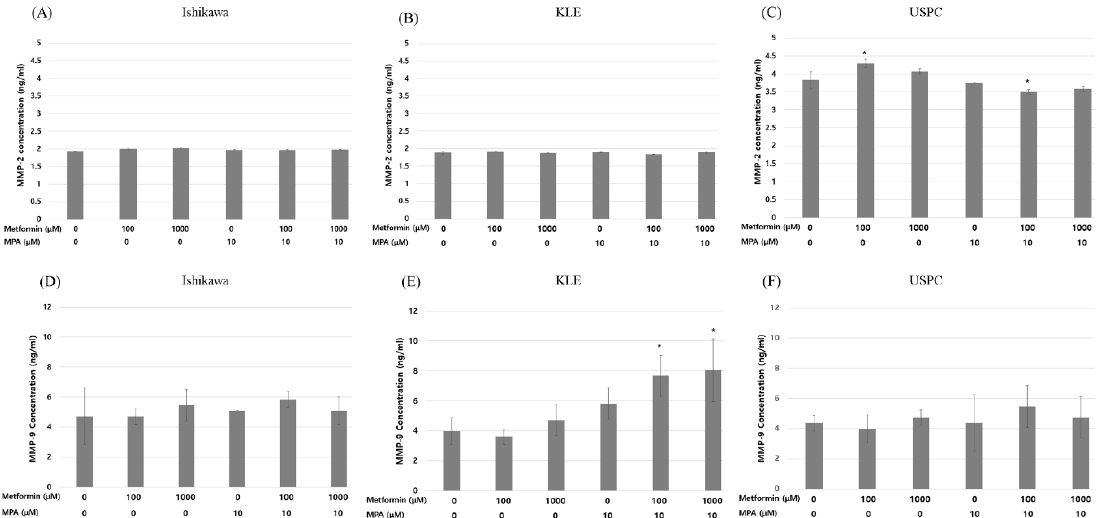
Figure 4. Matrix metallopeptidase (MMP)-2 ( A , Ishikawa; B , KLE; C , USPC) and MMP-9 ( D , Ishikawa; E , KLE, F , USPC) in three endometrial cancer cell lines after treatment with different dose combinations of medroxyprogesterone (MPA) (0, 10 µM) and metformin (0, 100, 1000 µM). Each experiment was independently performed in triplicate: results are expressed as mean ± standard deviation. Multiple testing correction was performed using Bonferroni adjustment and Bonferroni corrected p-values were used for statistical significance. * p < 0.05.